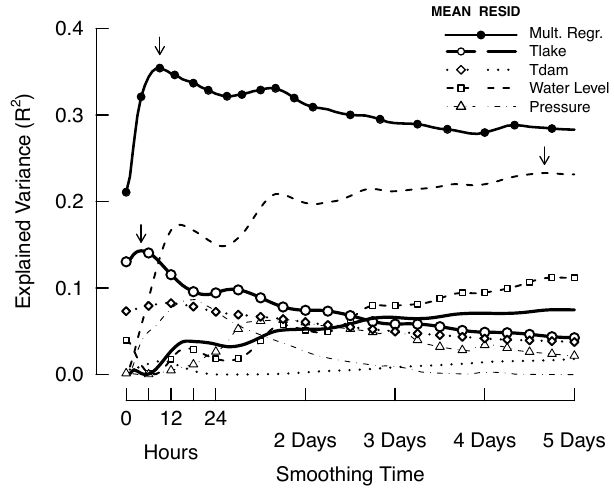
Fig. 8. Correlation analysis of CH 4 efflux with driving variables smoothed with a moving average of lengths up to 5 days (lines with symbols), and the residual variables (lines without symbols) result- ing from the smoothing process for: lake surface water temperature ( T lake ), dam 10-m temperature ( T dam ), water level height, and at- mospheric pressure; and the multiple regression shown in Table 2. For each smoothing time a cross-correlation analysis was carried out to obtain the highest time-lag corrected R 2 (adj. R 2 for the mul- tiple regression) which is then displayed as a line for each variable. The arrows show the optimum smoothing time for the three vari- ables with highest overall R 2 . Although lake surface water tem- perature shows the greatest explanatory power for short averaging times, none of the single drivers reach the level that the linear com- bination used in the multiple regression approach